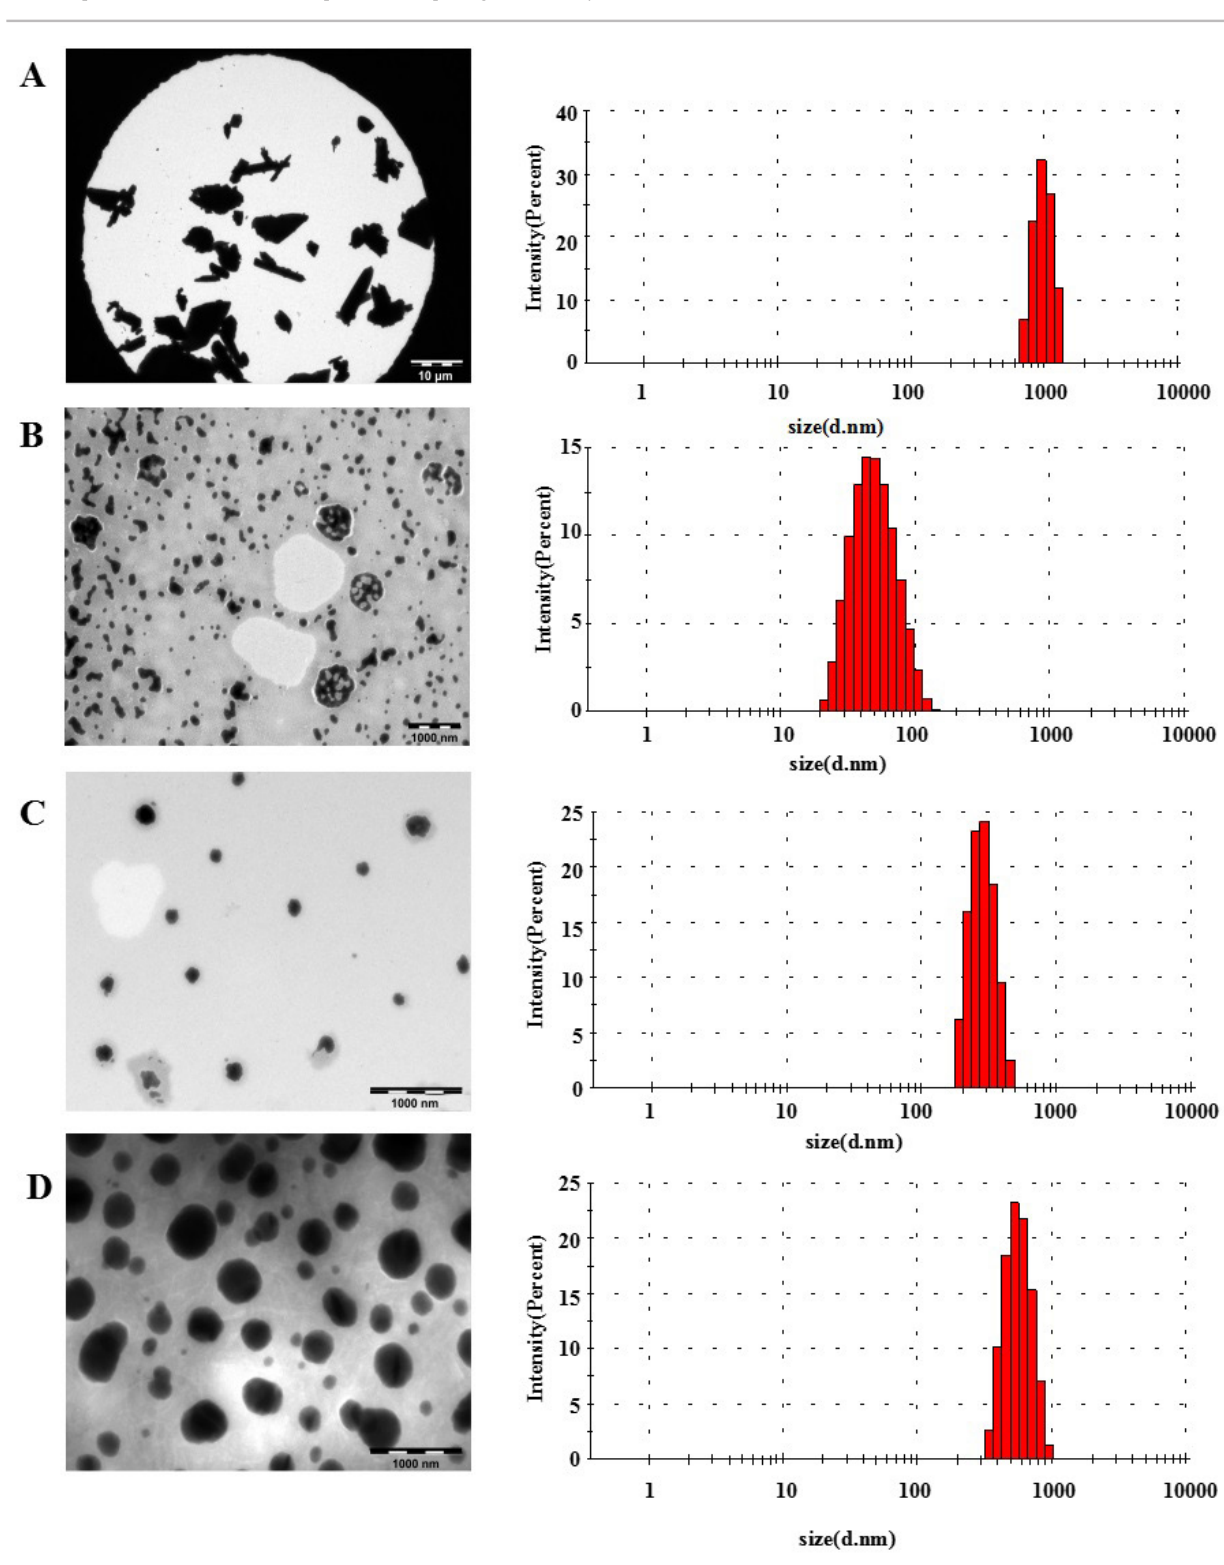
FIGURE 2 - Particle size distribution and TEM images of the ISL solution (A), R3 (B), R2 (C), and R1